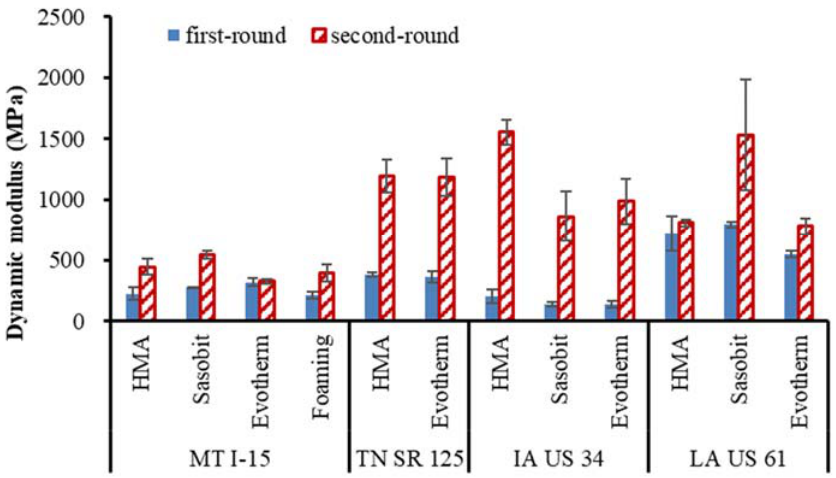
Figure 6. Comparisons of field core dynamic modulus at 30 °C and 0.1 Hz.